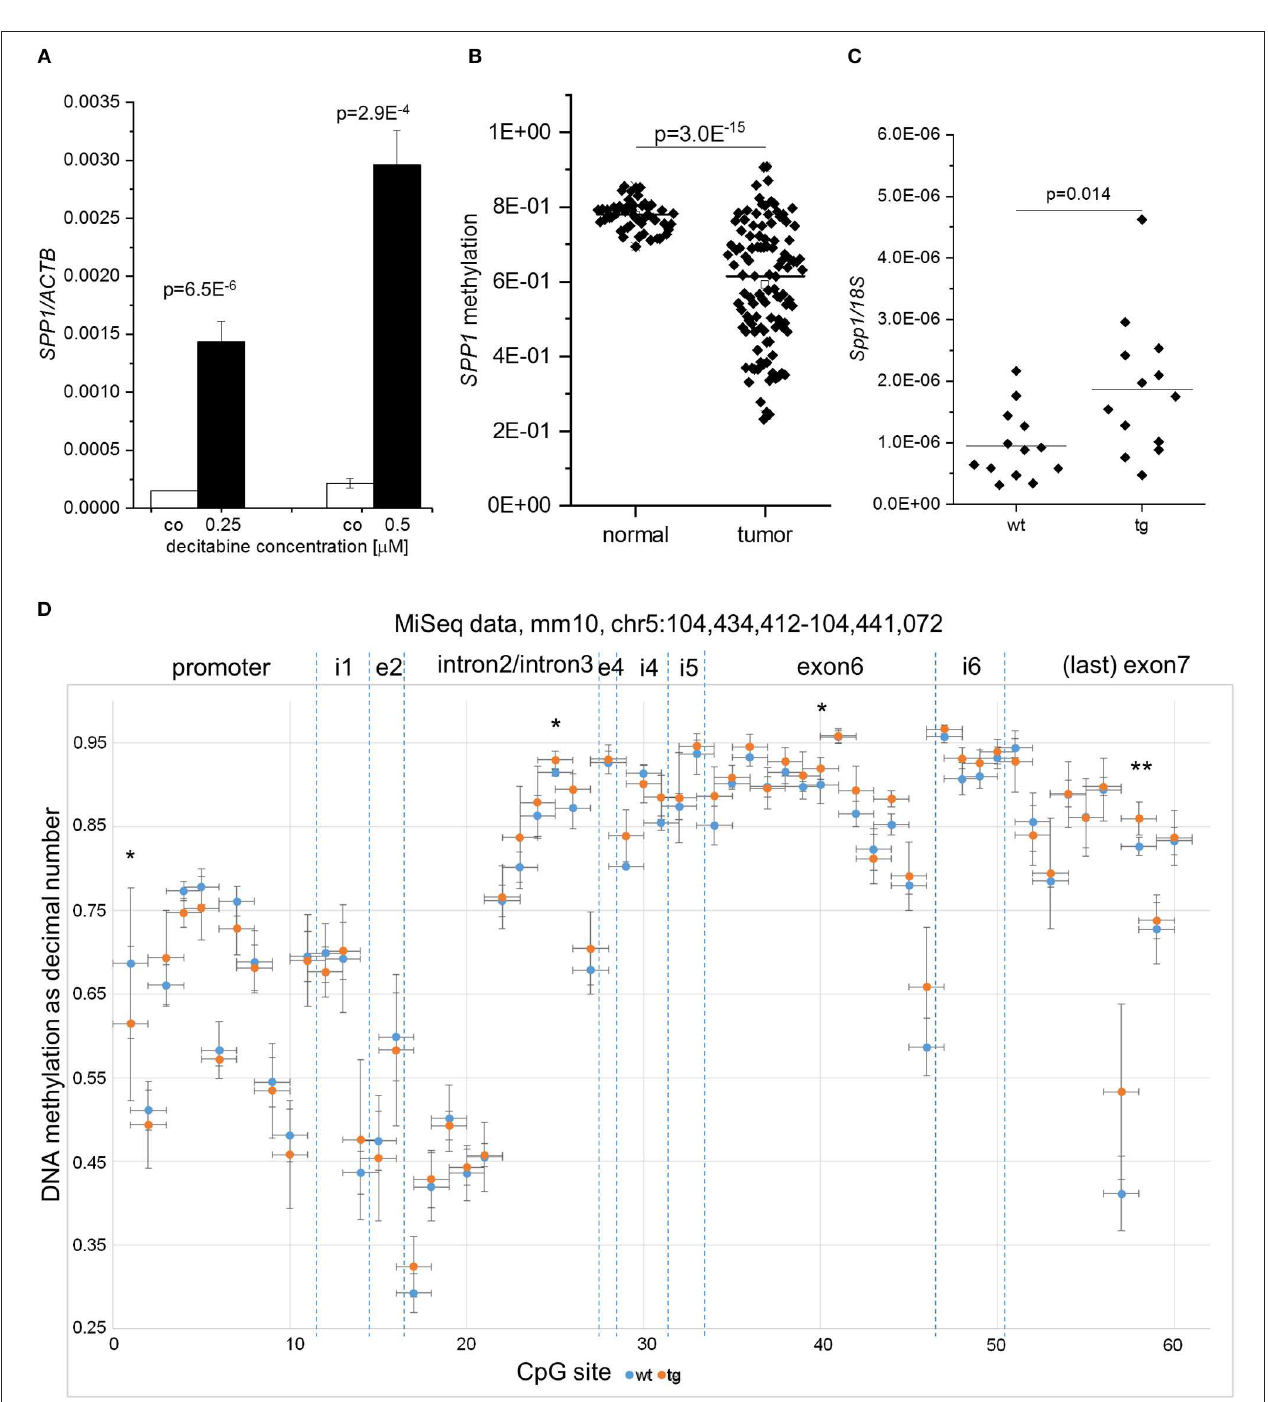
FIGURE 5 | Differential SPP1 methylation in human HCC and IMP2-2 tg mice. (A) SPP1 expression in Huh7 cells treated with either 0.25 or 0.5 µ M decitabine for 72h quantified by qPCR. Decitabine-containing medium was changed every 24h. (B) SPP1 promoter methylation in the TCGA liver cancer set in tumor vs. non-tumorous tissues. (C) Spp1 expression in IMP2-2 tg and wt mice on normal chow quantified by qPCR. 18S was used as housekeeping gene. (D) Methylation of CpG sites within the Spp1 gene in IMP2-2 tg (orange) vs. wt (blue) mice analyzed by amplicon sequencing. CpG sites are plotted along the x-axis according to their location in the gene, i.e., in the promoter region, introns [intron1 (i1), intron2/intron3, intron4 (i4), intron5 (i5), and intron6 (i6)], and exons (exon2 (e2), exon4 (e4), exon6, exon7). * p < 0.05; ** p < 0.01.